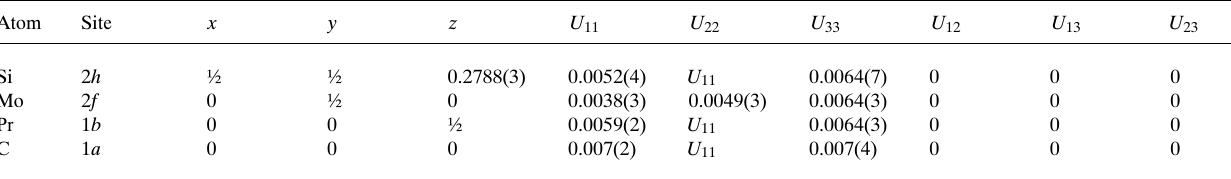
Table 2. Atomic coordinates and displacement parameters (in Å 2 )